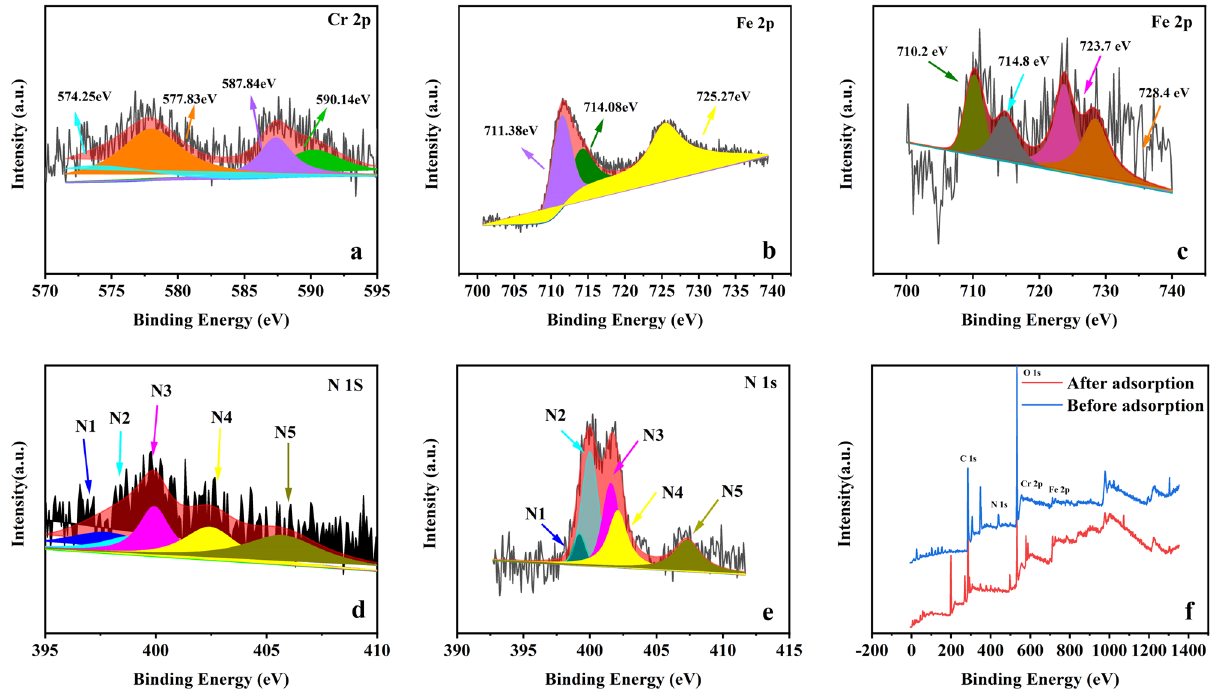
Figure 6. XPS testing of material: ( a ) XPS spectra of Cr 2P after adsorption of NMC-2, ( b ) XPS spectra of Fe 2P before adsorption of NMC-2, ( c ) XPS spectra of Fe 2P adsorbed by NMC-2, ( d ) XPS spectra of N 1s before adsorption of NMC-2, ( e ) XPS spectra of N 1s after adsorption of NMC-2, ( f ) full spectrum of NMC-2 before and after